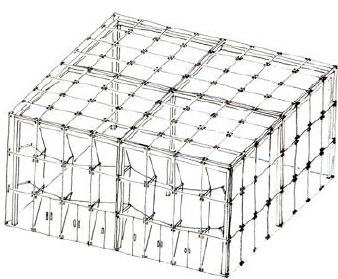
Figure 3: Glass cube proposal for the Centraal Museum in Utrecht.